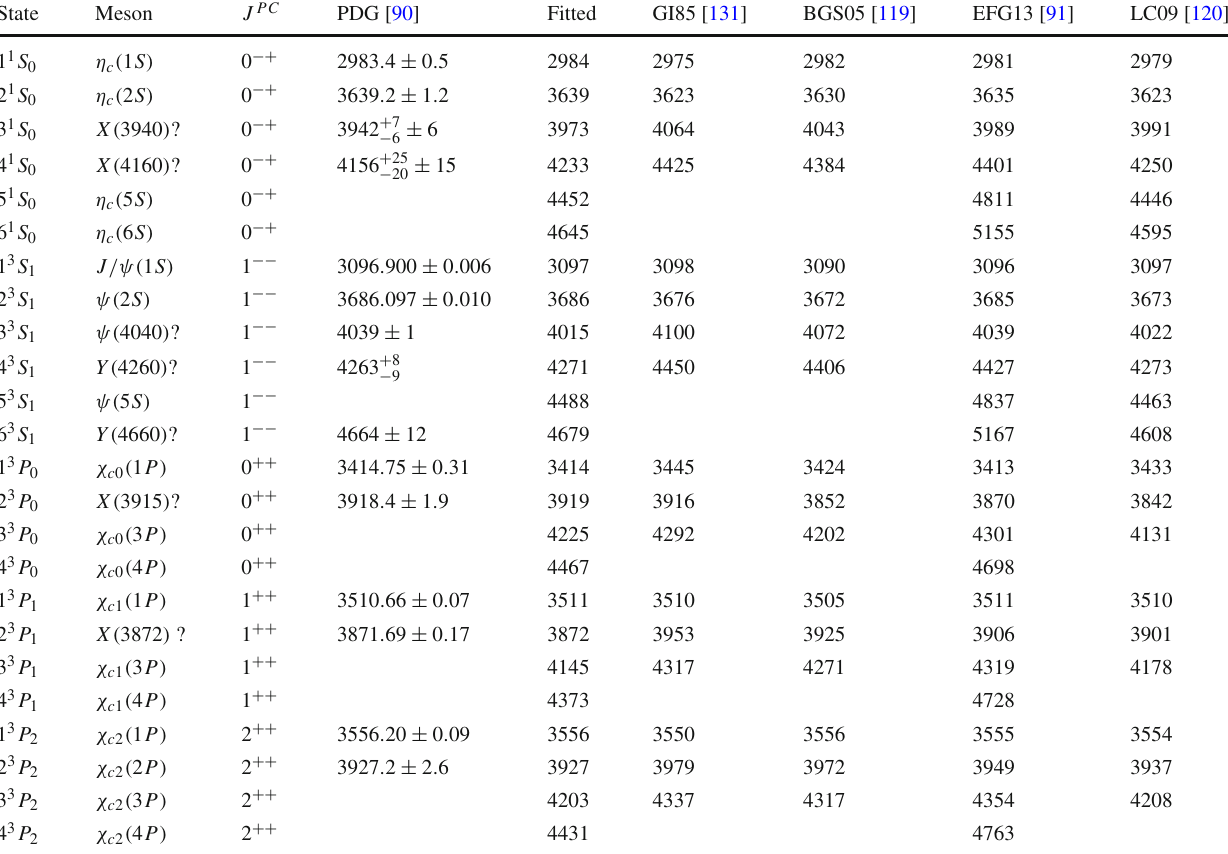
Table 3 Charmonium masses (in units of MeV) fitted by the radial Regge trajectories [Eq. (26)]. The experimental masses are from PDG [90]. The fitted results by using the Regge trajectories [Eq. (26)] are